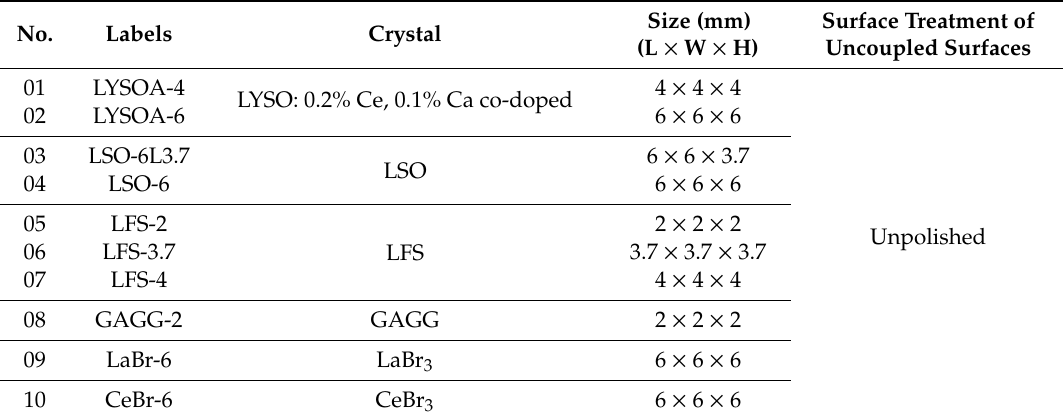
Figure 1. ( a ) Silicon photomultipliers (SiPMs) and scintillators; ( b ) packaged 6 mm LaBr 3 cubes (LaBr-6) crystals; ( c ) GAGG-2 crystals. Table 1. Parameters of the lutetium–yttrium oxyorthosilicate (LYSO), lutetium oxyorthosilicate (LSO), LFS, GAGG, LaBr 3 and CeBr 3 crystals.